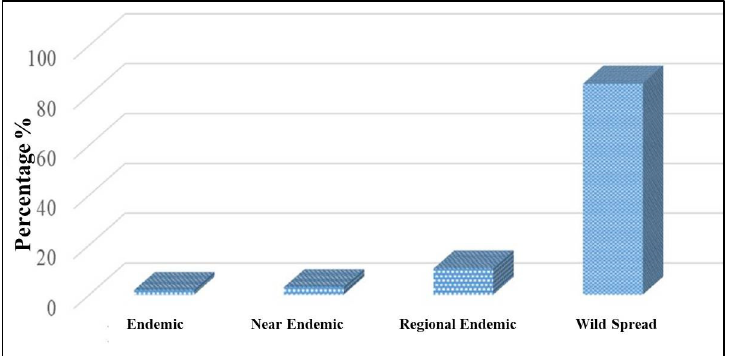
Figure 2. Percentage of endemism among bee plant species in Al-Baha region, southwestern Saudi Arabia.